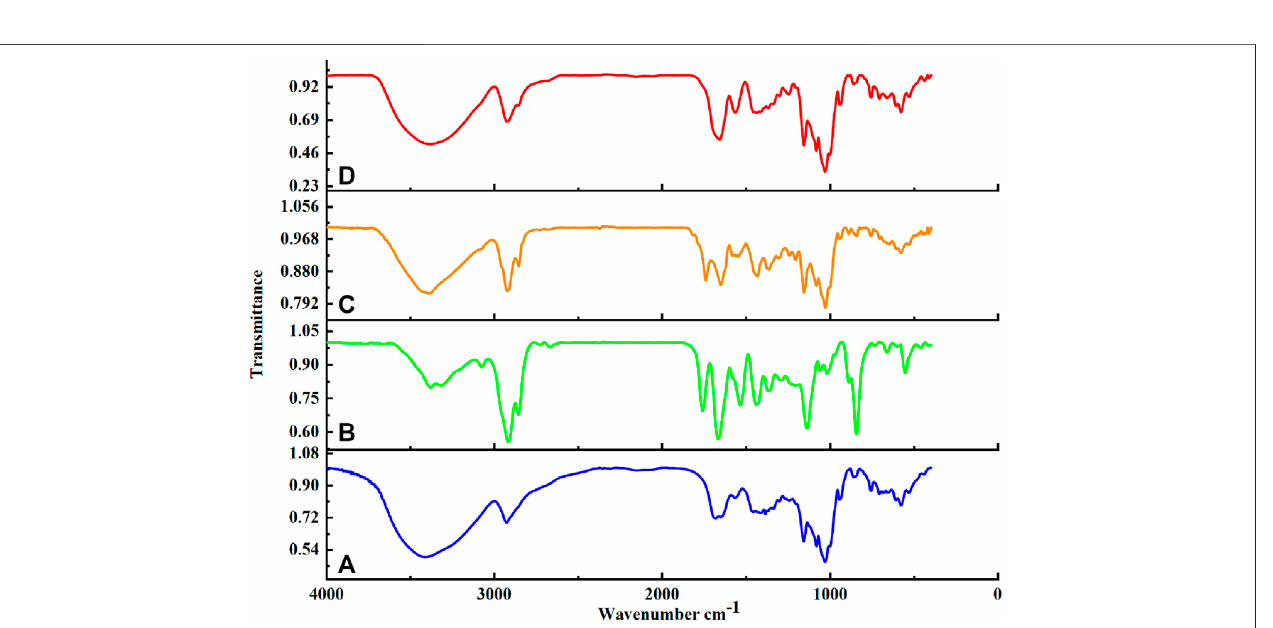
Frontiers in Chemistry |